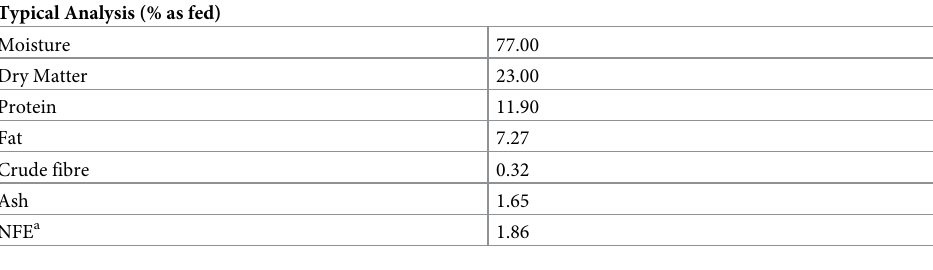
Ingredients: chicken, animal liver, meat by-products, poultry by-products, natural and artificial flavors, salt, tricalcium phosphate, guar gum, potassium chloride, dl-methionine, vitamins, minerals, choline chloride, added color, taurine, water sufficient for